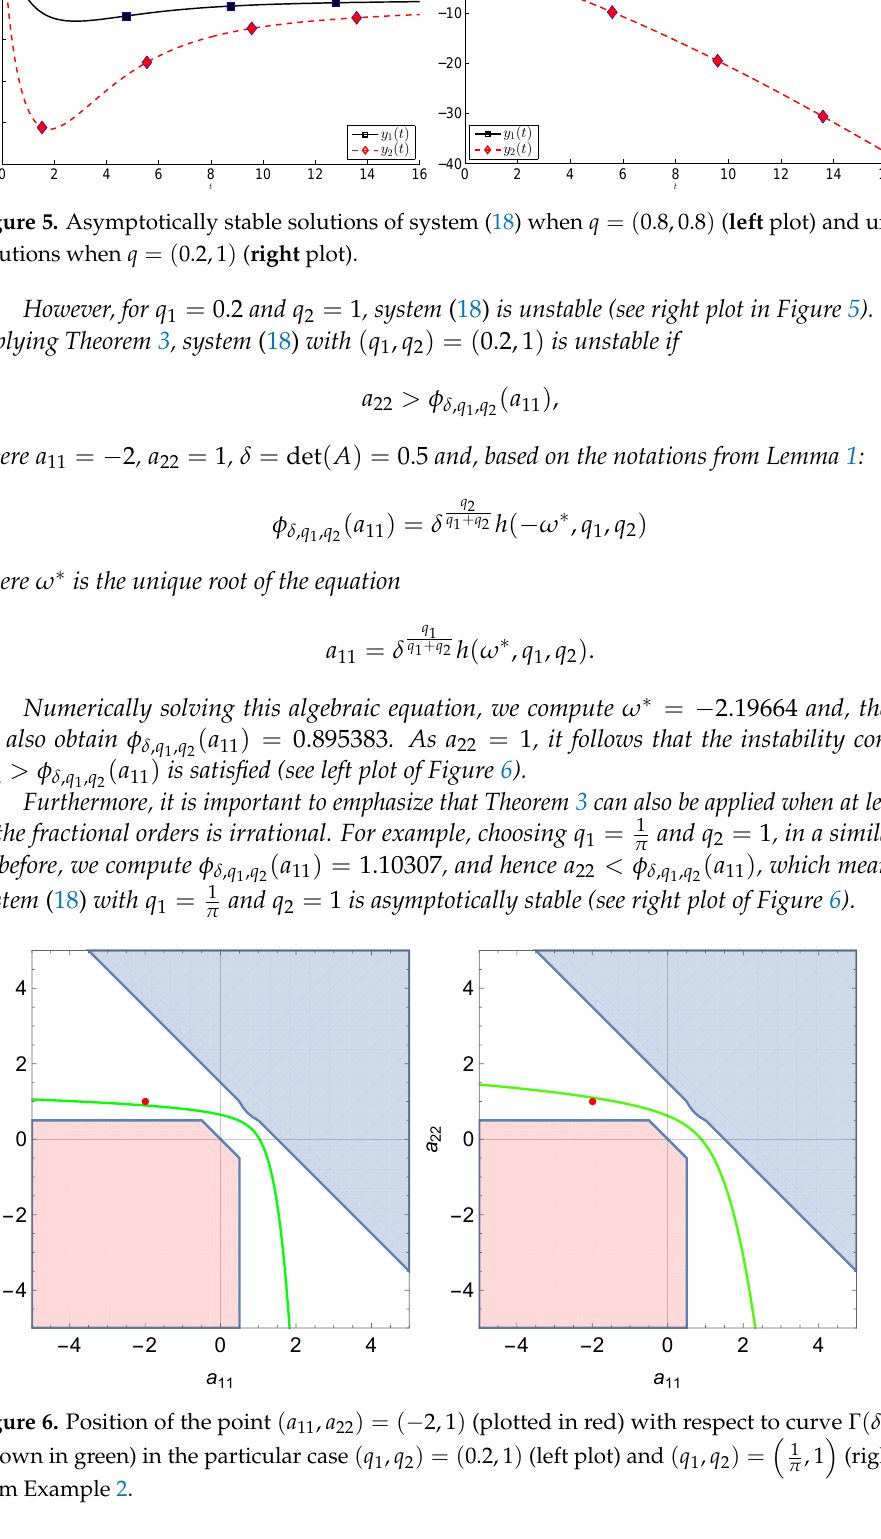
(cid:16) (cid:17) 1 ,1 (right plot) π